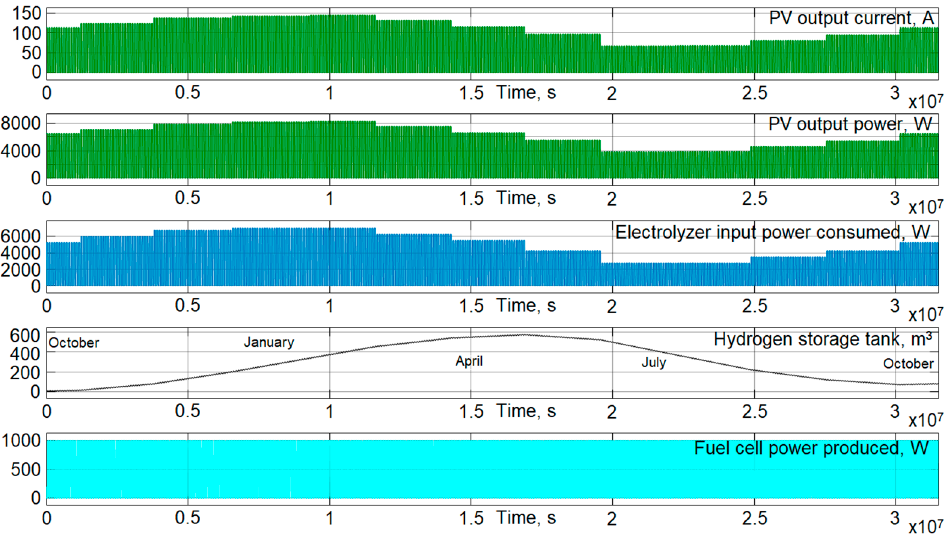
Figure 19. The result of the simulation and calculation of the required hydrogen tank capacity for the location Manipal, India.